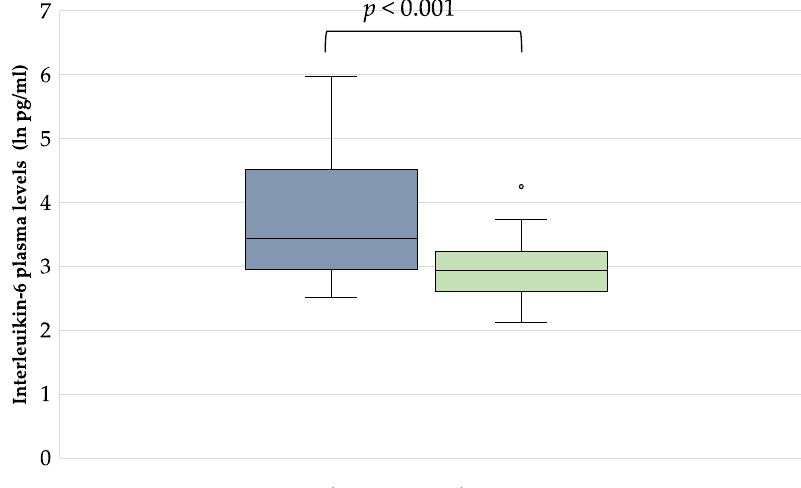
Figure 2. Interleukin-6 levels in plasma of HD patients with and without fatigue.